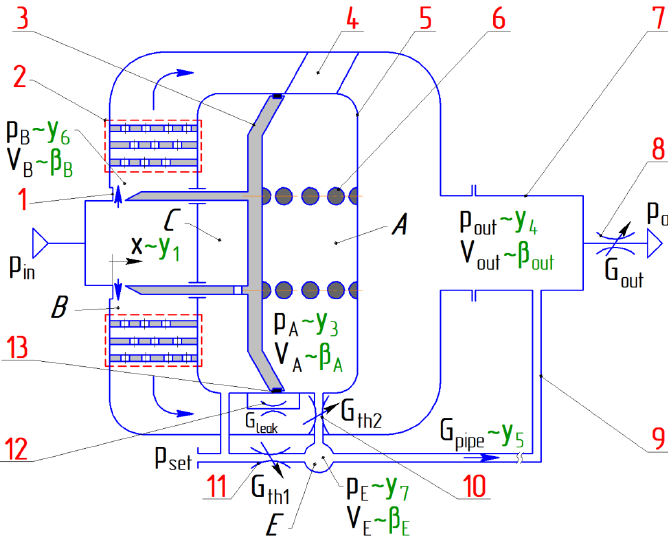
Figure 1. Schematic diagram and main nomenclature for the GPR with muffler. 1—valve seat; 2—muffler; 3—piston/sensing element/valve; 4—pylon; 5—valve body-; 6—spring; 7—outlet pipe; 8— metering valve; 9—feedback pipe; 10, 11—variable throttle; 12—leak simulator; 13—seal.